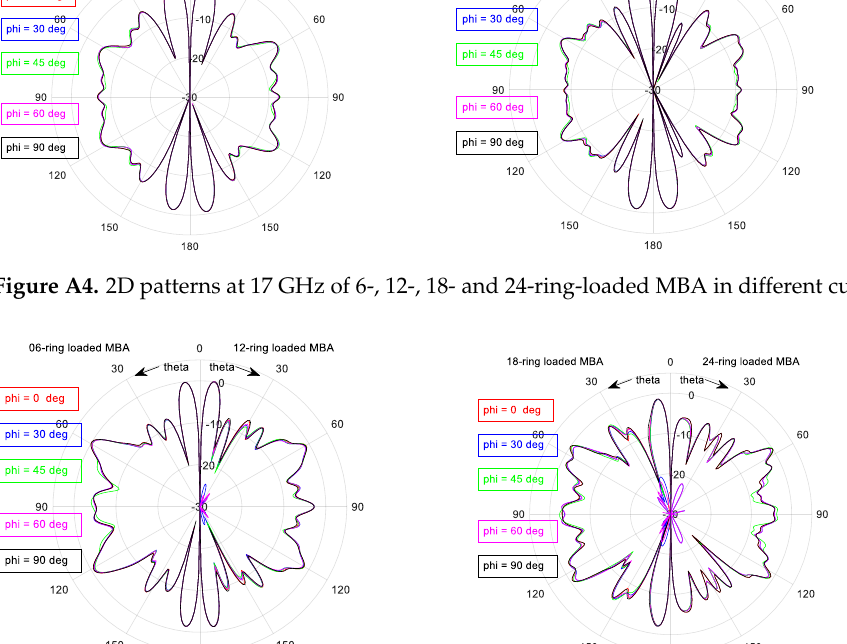
Figure A5. 2D patterns at 22 GHz of 6-, 12-, 18- and 24-ring-loaded MBA in different cutting planes.